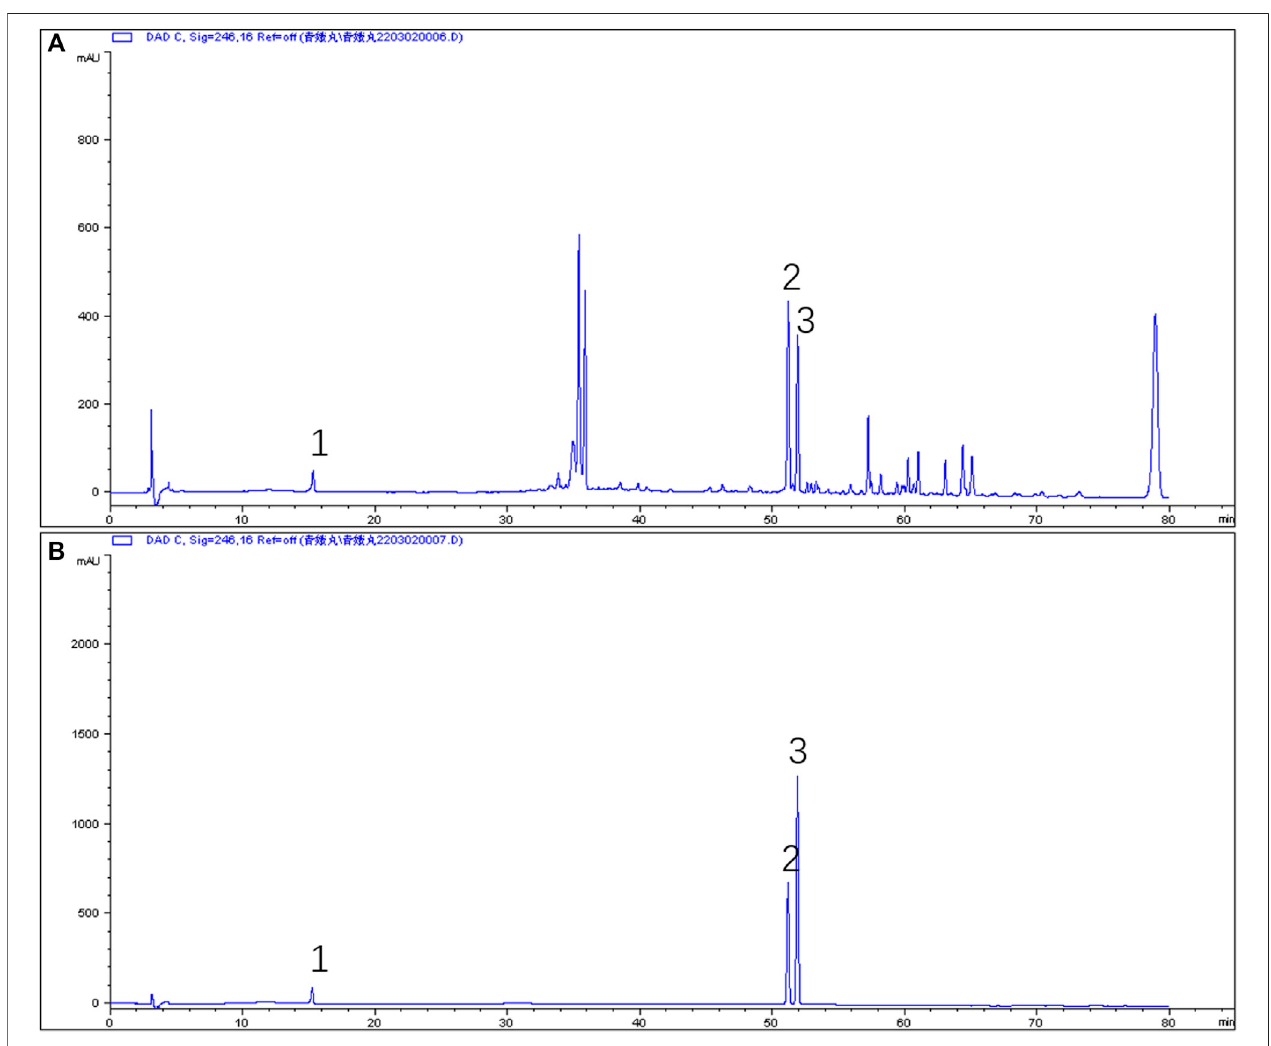
FIGURE 2 | (A) HPLC of QEP (B) HPLC of geniposide, psoralen, and isopsoralen (1, geniposide; 2, psoralen; 3, isopsoralen).